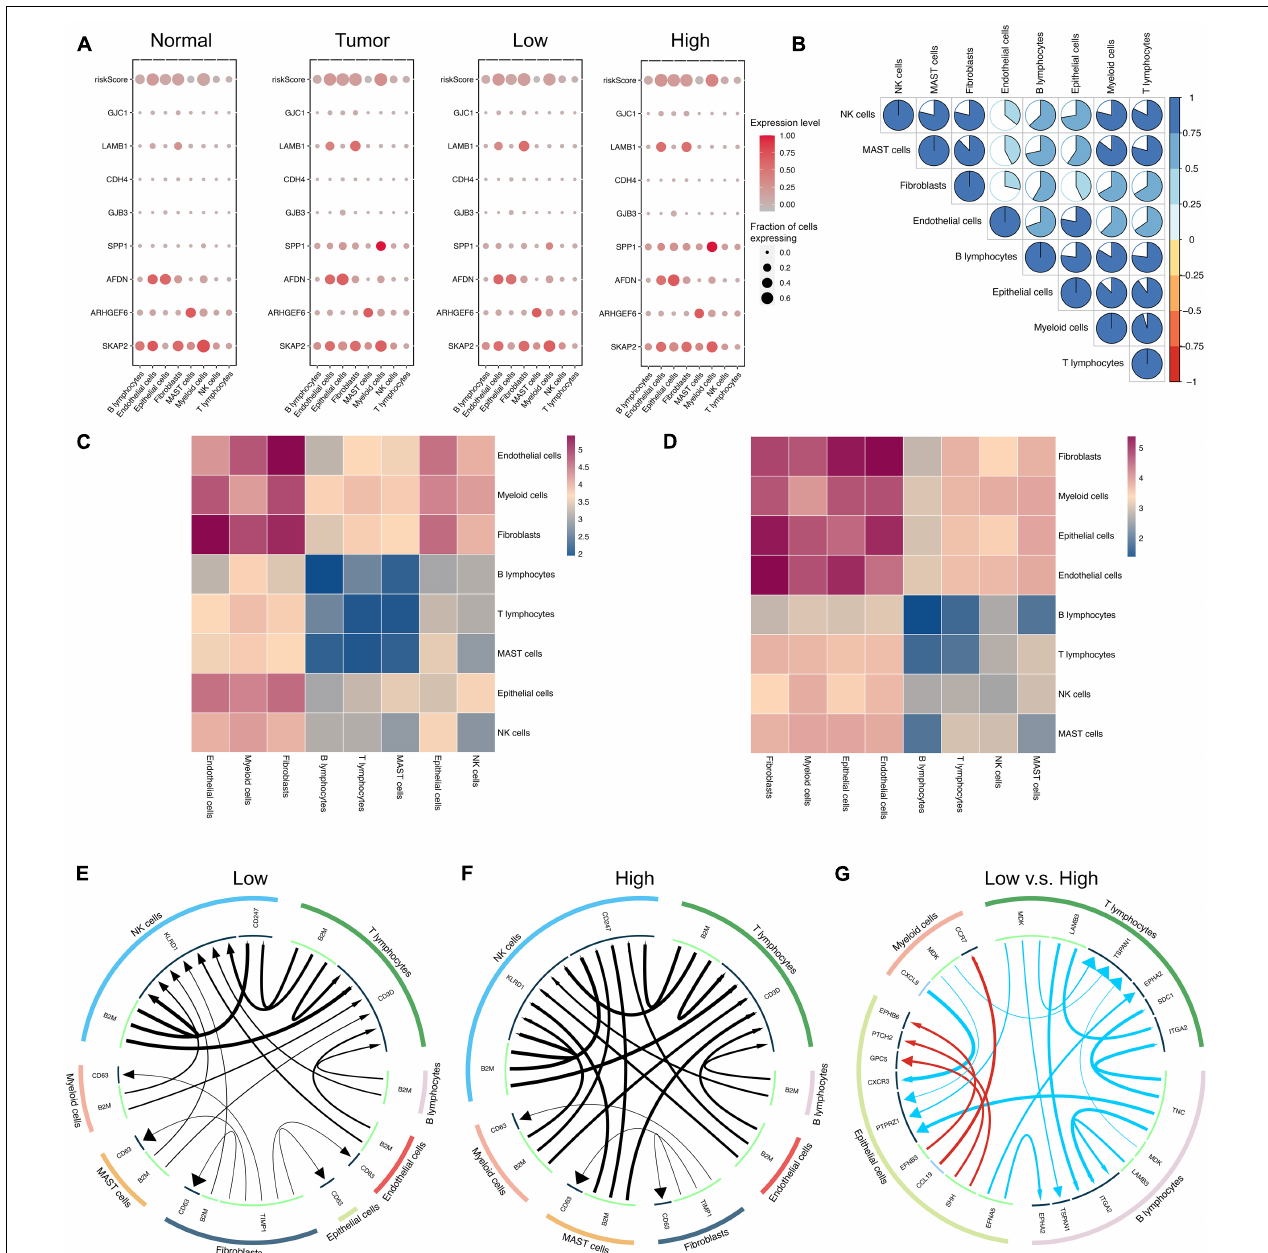
FIGURE 5 | Modeling of intercellular communication based on a single cell RNA sequencing dataset. (A) Heatmap for the ICAG expression and the risk score in different groups. (B) Correlation of the risk scores in different cells. (C,D) Heatmaps for the intercellular communication generated by using CellphoneDB in the low-risk group (C) and the high-risk group (D) . (E,F) The main ligand–target expression between the different cells in the low-risk group (E) and the high-risk group (F) . (G) The top differences in the expression of ligand or target genes between the low- and the high-risk groups. (E–G) were generated by using the iTALK R